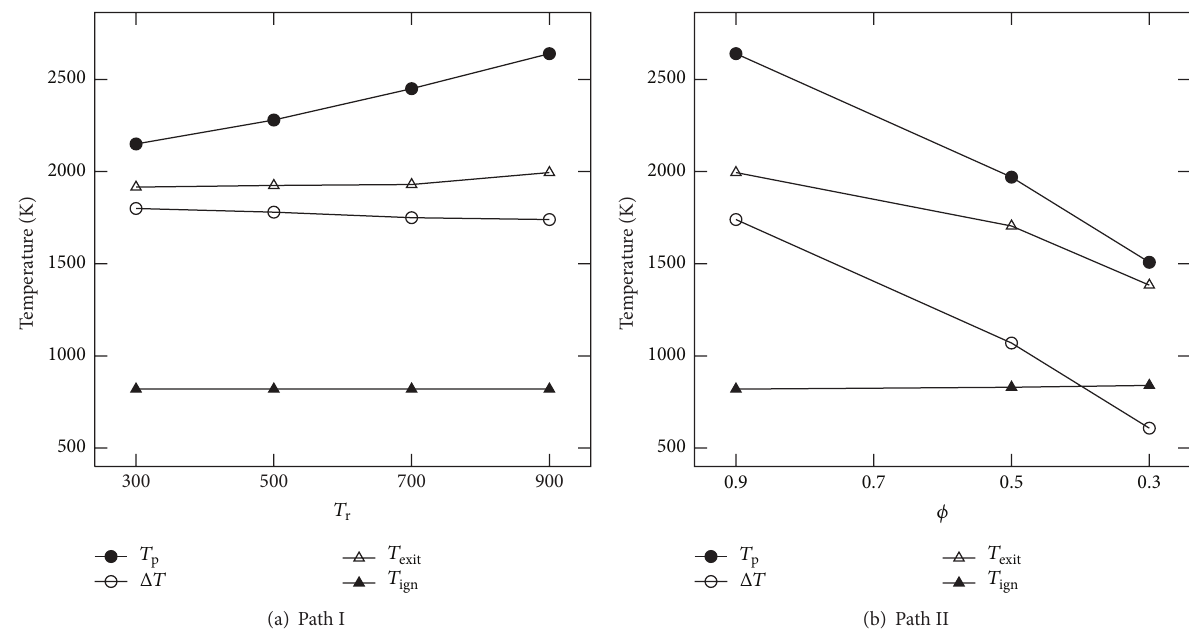
Figure 4: Characteristic